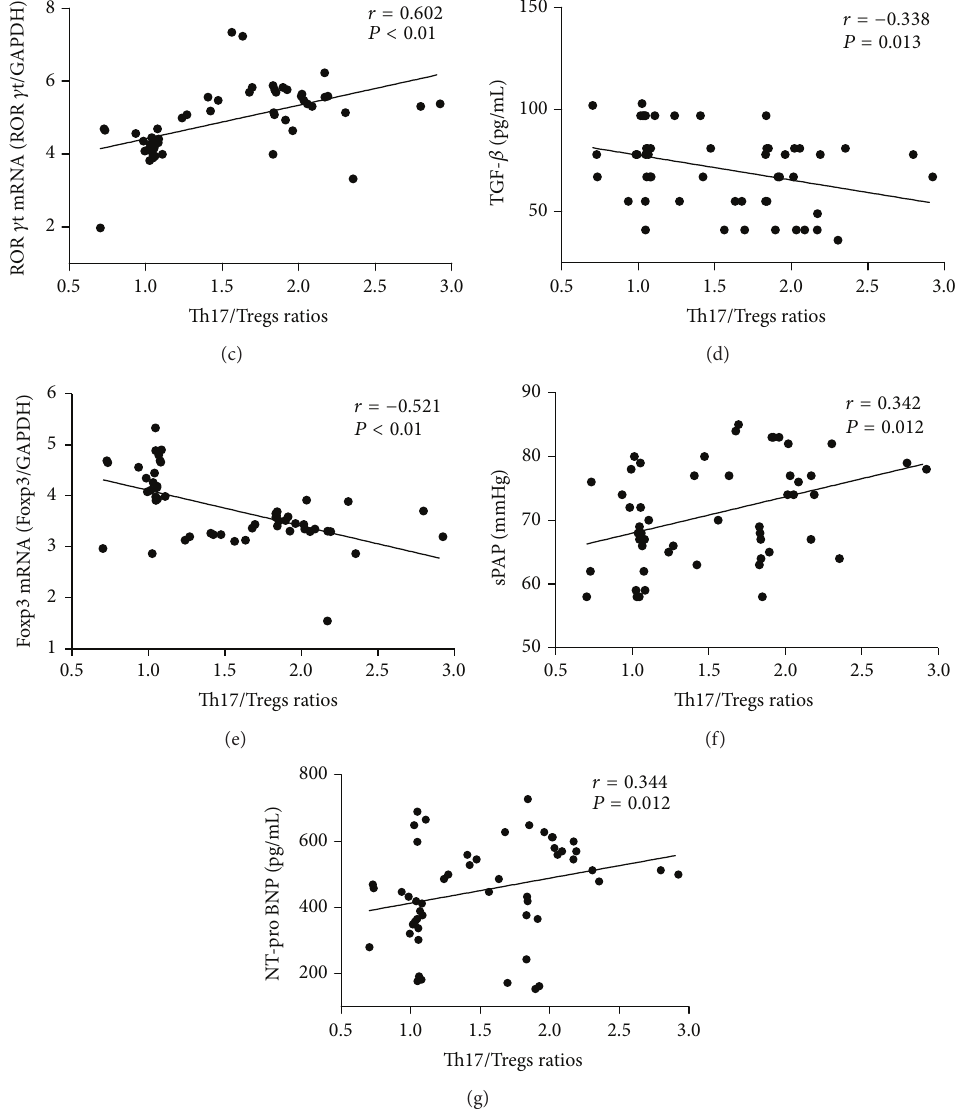
Figure 3: Correlation between Th17/Treg ratios and related cytokines; expression of ROR 𝛾 t and Foxp3 mRNA and markers of disease severity in patients with CTD-aPAH. (a) Ratios of Treg to CD 4 + cells negatively correlate with ratios of Th17 to CD4 + cells. (b) Ratios of Th17/Treg positively correlate with IL-17 concentrations. (c) Ratios of Th17/Treg positively correlate with expression of ROR 𝛾 t mRNA. (d) Ratios of Th17/Treg negatively correlate with TGF- 𝛽 concentrations. (e) Ratios of Th17/Treg negatively correlate with expression of Foxp3 mRNA. (f) Ratios of Th17/Treg positively correlate with levels of sPAP. (g) Ratios of Th17/Treg positively correlate with NT-pro BNP